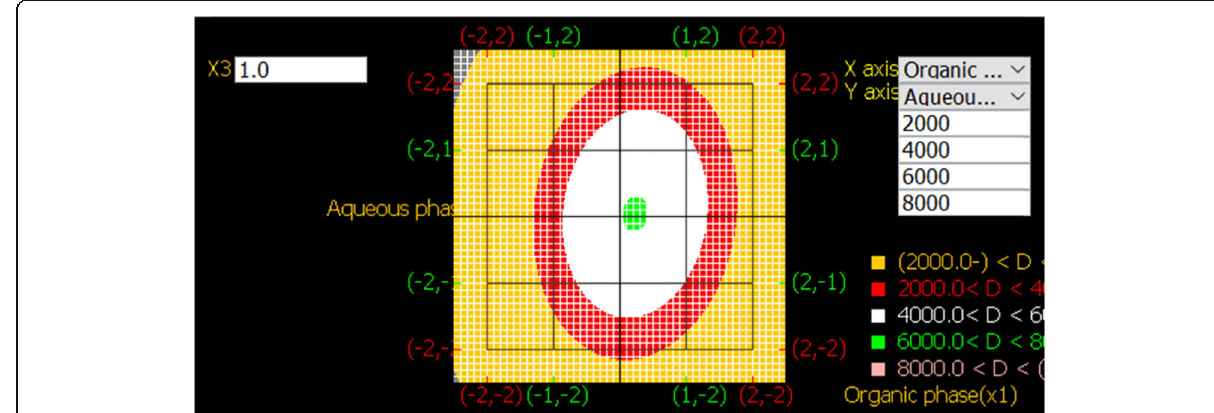
Fig. 2 Contour plot of velpatasvir at 1.0 ml flow rate